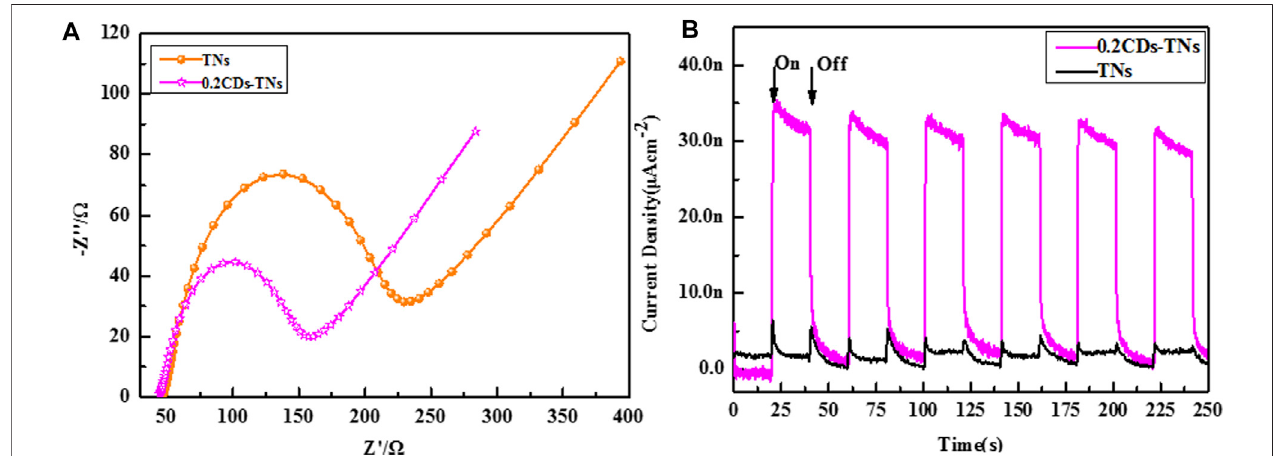
FIGURE 8 | EIS curves (A) and transient photocurrent density (B) of TNs and 0.2CD-TNs under visible light irradiation.